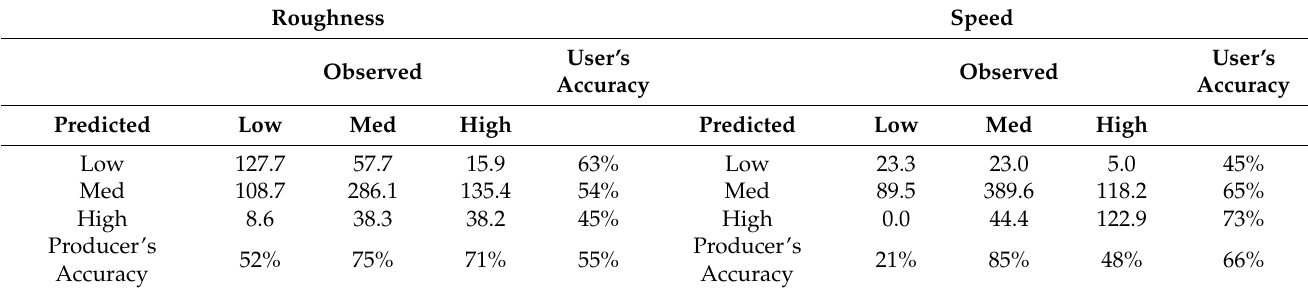
Table 2. Confusion matrix for predicting roughness and speed for individual road segments (n = 771) using RapidEye satellite imagery trained with data collected with the RoadLab-Pro app. Values are the total km of road segments classified into each category.